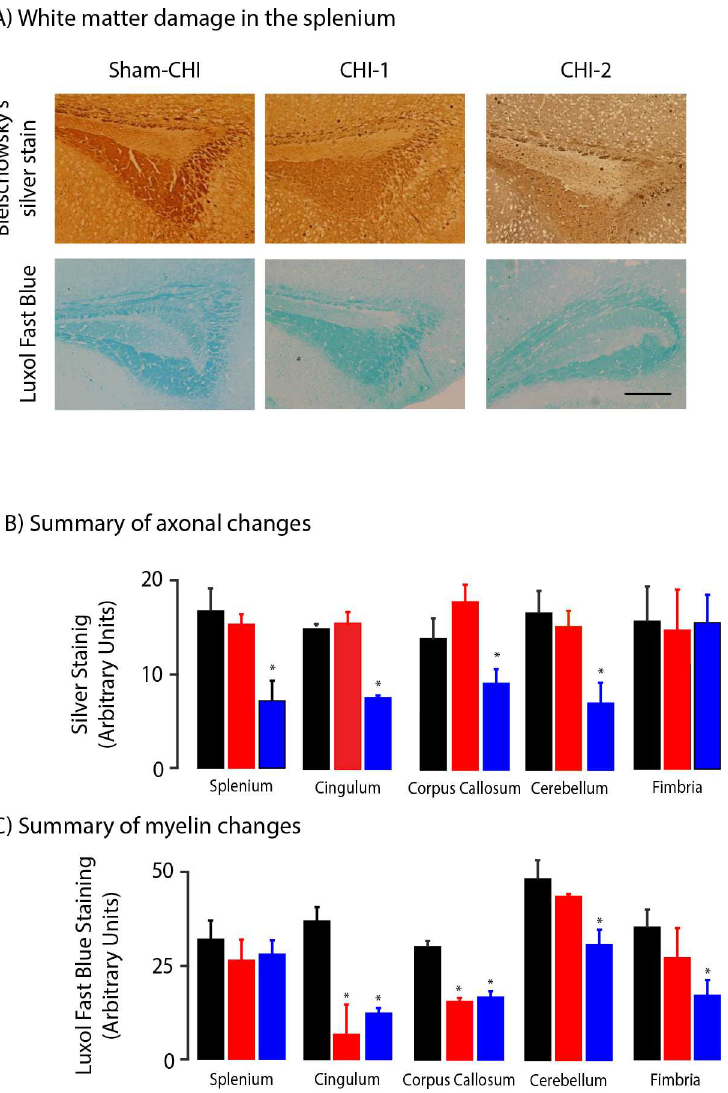
Fig 5. Assessment of white matter injury in CHI-1 and CHI-2 mice. Panel A, Representative photomicrographs of sagittal sections of spleniumstained with Bielschowsky’s modified silver stain (top), or the luxol fast blue myelin stain (bottom). The scale bar is 200 μ m. Panel B, Summary of changes in silver stain intensity in CHI-1 and CHI-2 mice. Panel C, Summary of myelin loss in CHI-1 and CHI-2 mice. In some brain regions, silver stain or myelin stain intensity in the CHI-1 or CHI-2 groups was significantly lower than in sham-CHI mice (post hoc, * p <